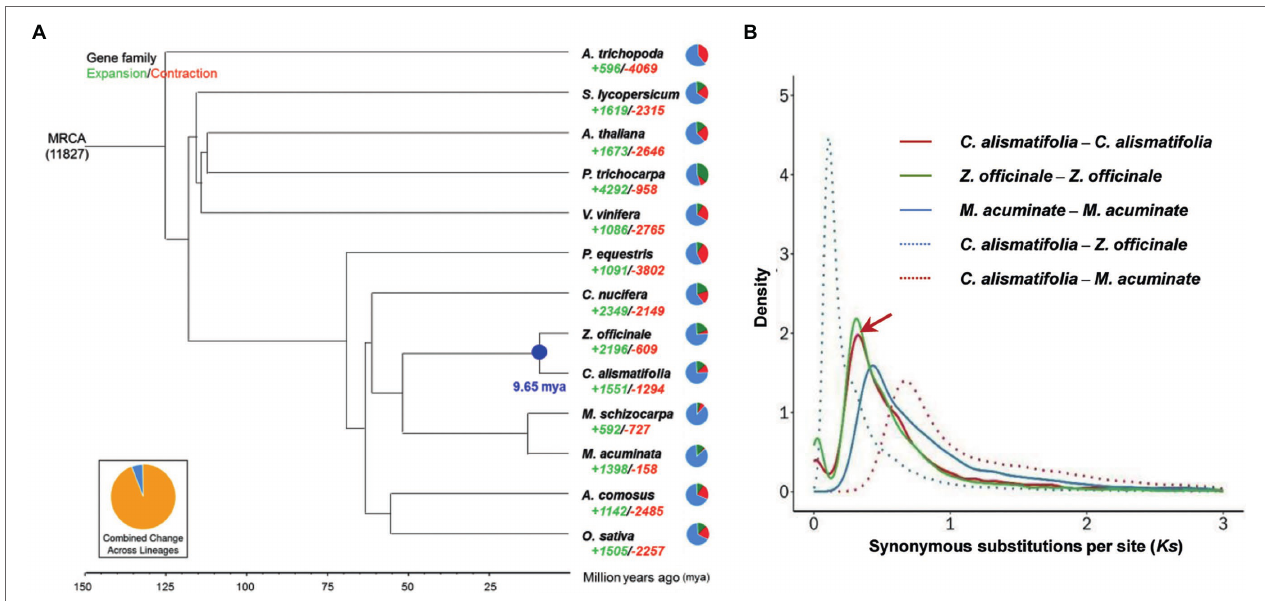
FIGURE 2 | Evolution of C. alismatifolia . (A) Phylogenetic tree showing the evolution of gene families and divergence times. The green and red numbers represent the numbers of expanded and contracted gene families, respectively. In the pie charts, green, red, and blue portions show expanded, contracted, and constant gene families, respectively. Numbers at nodes represent divergence times (million years ago). (B) Distribution of synonymous substitutions per synonymous site ( Ks ). Peaks of intra-species Ks distributions indicate ancient whole-genome duplication events, and peaks of inter-species Ks distributions indicate divergence events. The arrow shows the recent whole genome duplication peak in C.